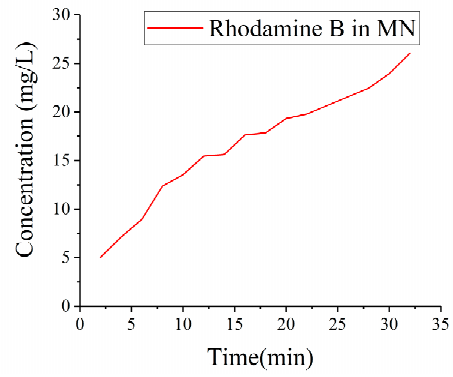
Figure 12. Integrated Density of rhodamine B in white rectangle area in MNs.